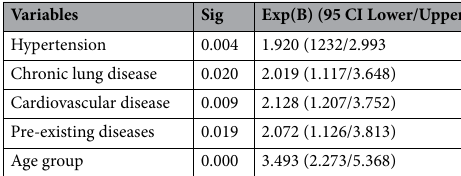
Table 4. Mortality, Logistic Regression, Compared deceased patients (146) vs total population included missing